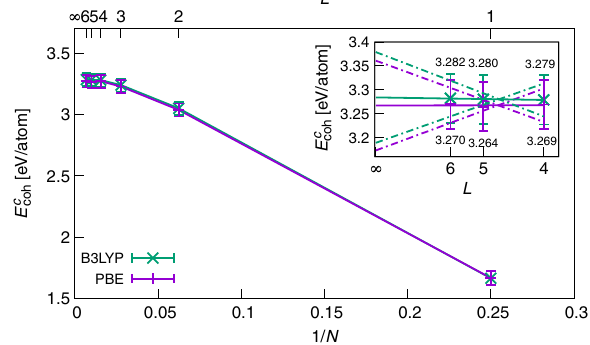
FIG. 3. Finite-size scaling of fixed-node corrected cohesion energy E c , in DMC@PBE (purple curve) and DMC@B3LYP coh (green curve) treatment. The error bars are smaller than the size of the points. The inset shows the enlargement of the linear scaling for large N with extrapolation to infinite system